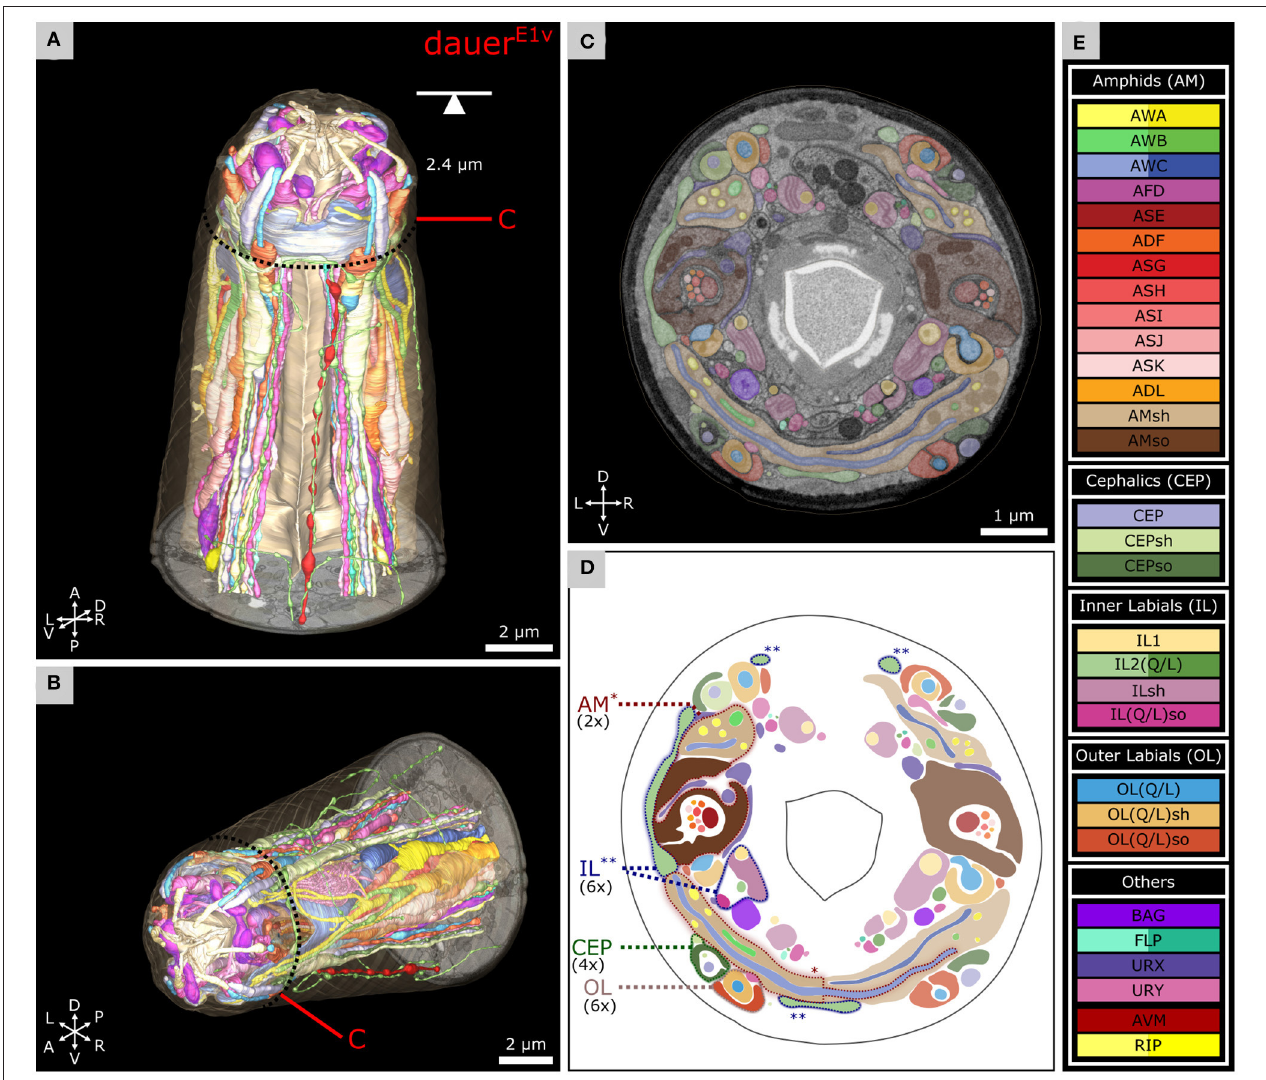
FIGURE 2 | Volumetric reconstruction of 93 anterior cell endings including all sensory neurons and their support cells of a C. elegans dauer larva. (A) Ventral view of the volumetric reconstruction in the context of the body wall and buccal cuticle. (B) View from the anterior-right side. (C) Transverse FIB-SEM section at 2.4 µ m from anterior with cell labels according to color code (see E). (D) Scheme of cell labels from C. The four sensilla types called AM, IL, CEP, and OL are highlighted for one sensillum as an example each, indicating their location. Asterisks indicate associated parts respectively (*: AM; **: IL). (E) Cell names and color codes (adapted